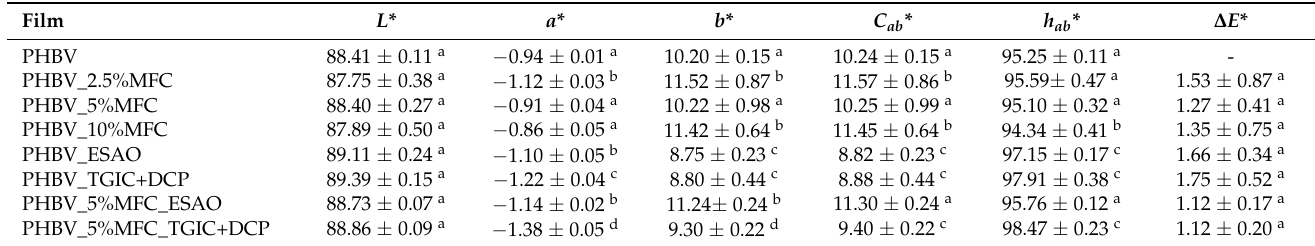
Table 2. Color parameters ( L *, a *, b *) hue angle ( h ab *), color saturation or chroma ( C ab *), and color difference ( ∆ E ab *) of the films of poly(3-hydroxybutyrate- co -3-hydroxyvalerate) (PHBV) with mi- crofibrillated cellulose (MFC) and compatibilized with epoxy-based styrene-acrylic oligomer (ESAO) and with triglycidyl isocyanurate (TGIC) and dicumyl peroxide